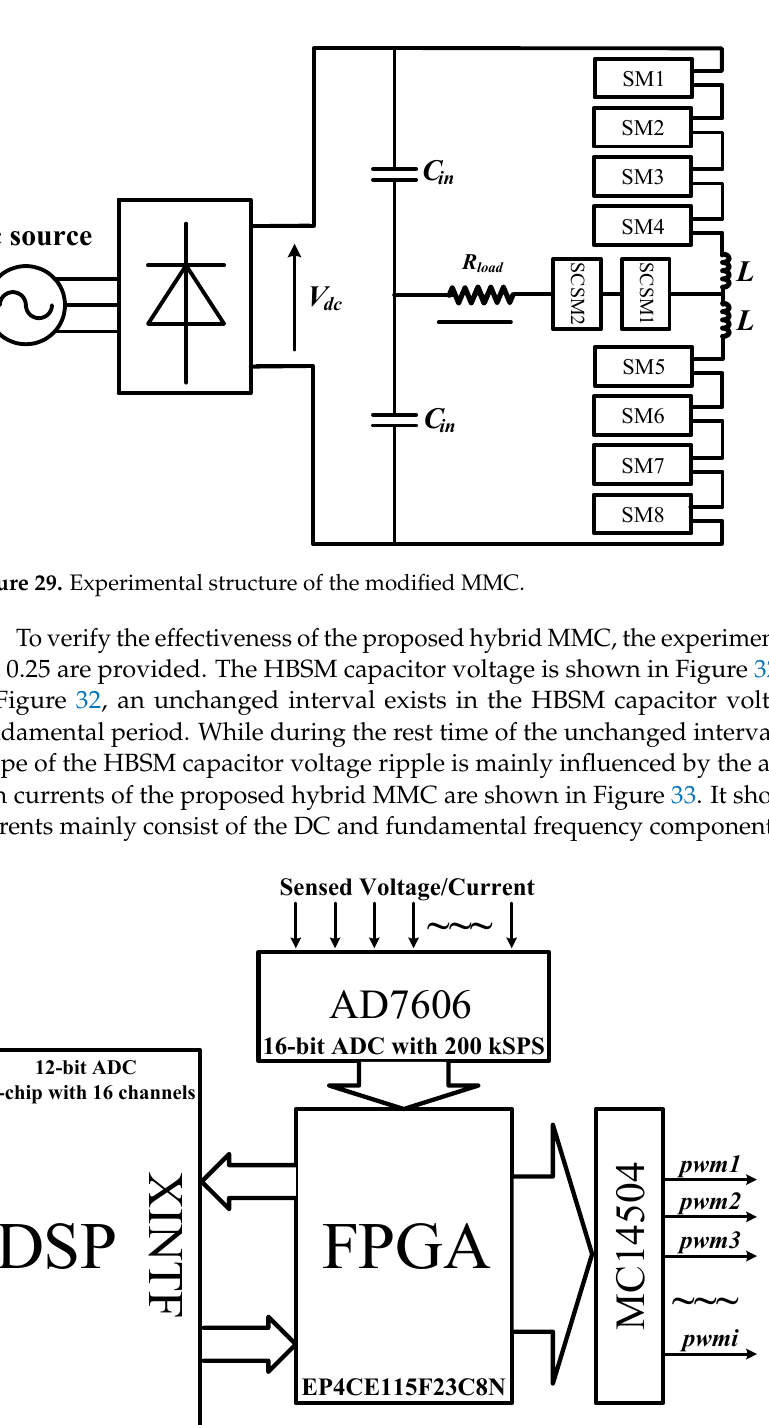
Figure 30 . Diagram of the control system . Figure 30. Diagram of the control